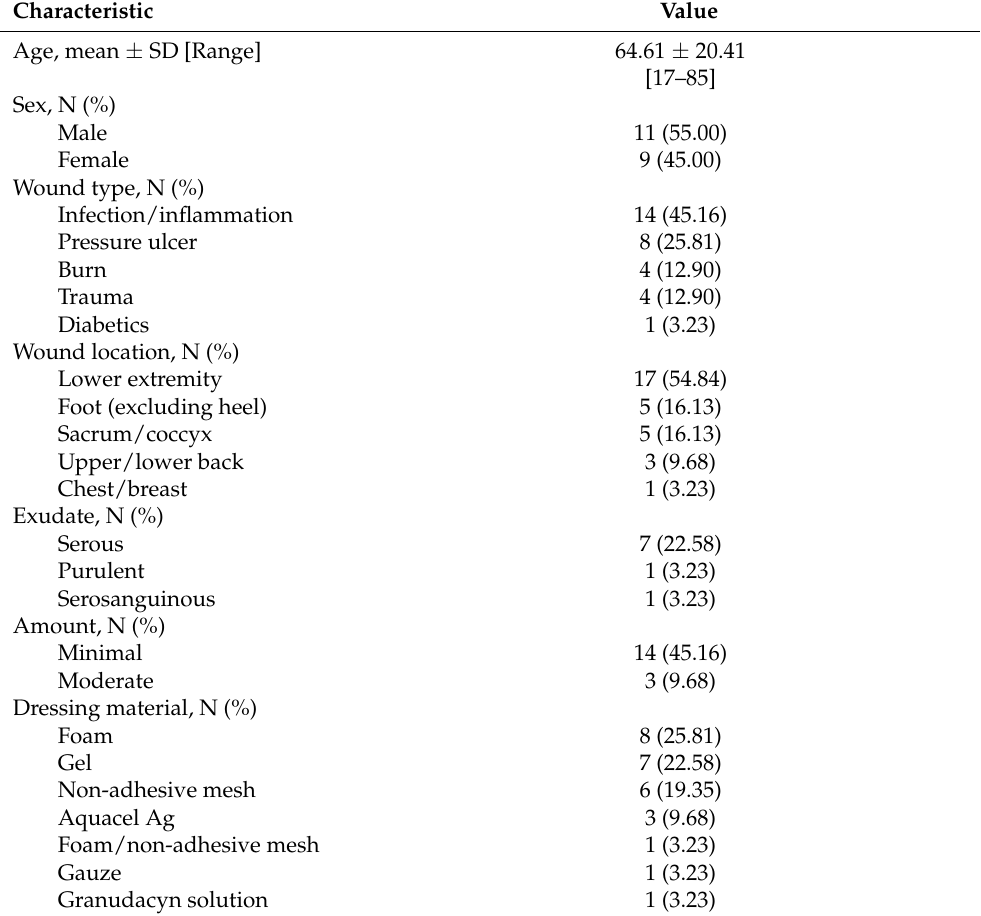
Table 3. Patient